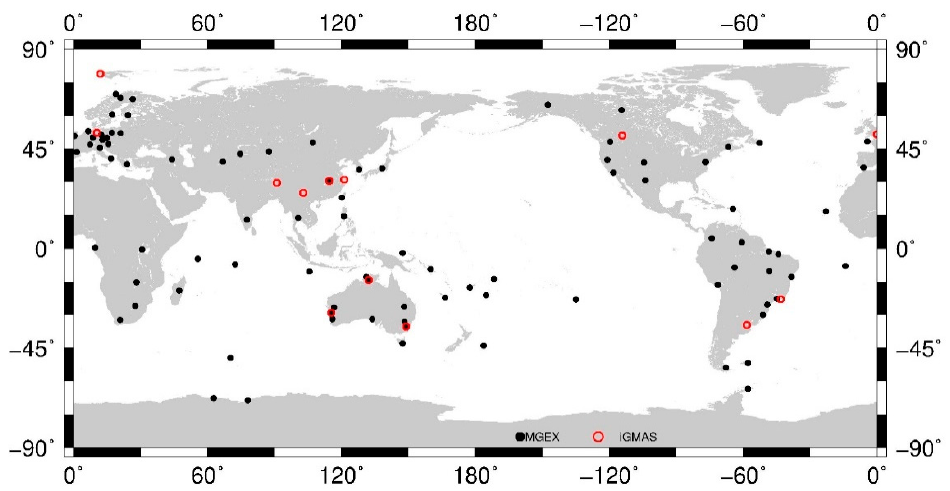
Figure 3. Distribution of the ground stations used for estimating PCOs and phase center variations (PCVs) of BDS IGSO and MEO satellites. Red circles indicate International GNSS Monitoring and Assessment System (iGMAS) stations, whereas the black ones represent International GNSS Service (IGS) multi-GNSS experiment (MGEX) stations.